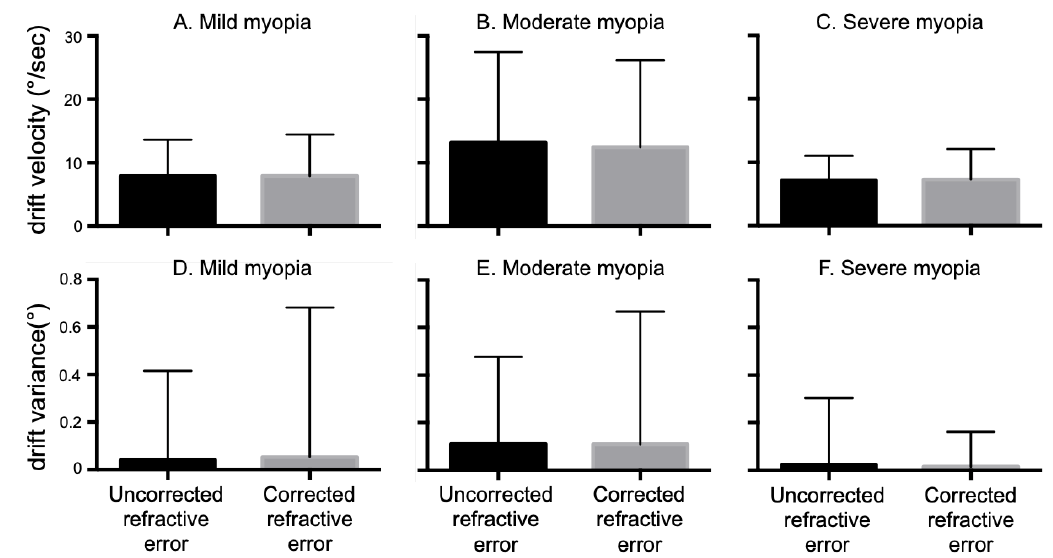
Figure 5. Mean and standard deviation of inter-saccadic drift velocities (A-C) during visual search. There were no significant differences in drift velocities with uncorrected vs corrected refractive error as a function of severity of myopia. Mean and stand- ard deviation of inter-saccadic drift variance (D-F) during visual search task. There were no significant differences in drift vari- ance of eye position in uncorrected vs corrected refractive error as a function of severity of